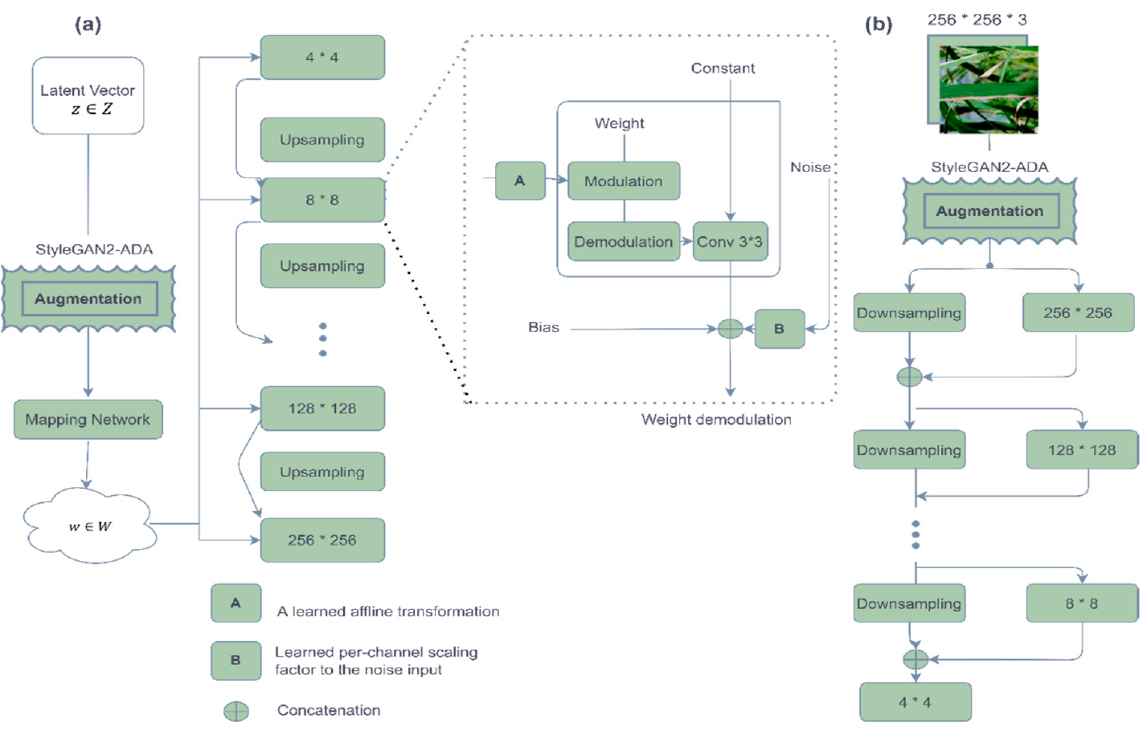
Figure 8. SG2-ADA network architecture. ( a ) SG2 generator ( b ) SG2 discriminator Hence, SG2 performs data augmentation after the input vector for both ( a ) & ( b )